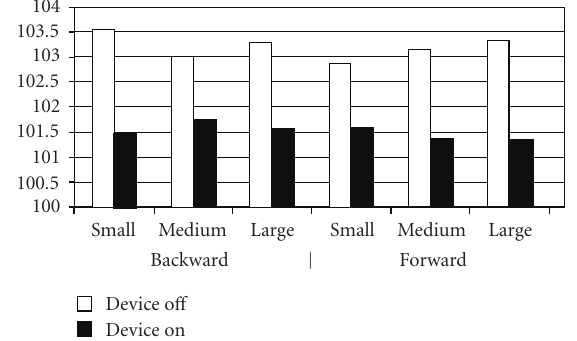
Figure 6: Weight symmetry results for all patients (small, medium, and large movements of the posturography